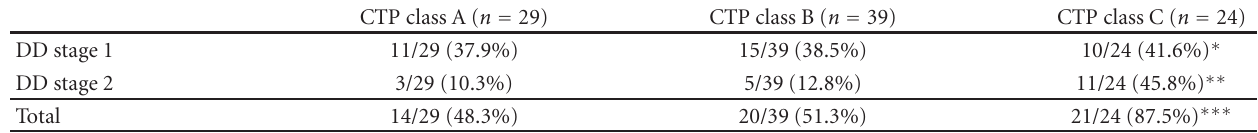
Table 3: Prevalence of diastolic dysfunction (DD) among the di ff erent stages of liver disease.